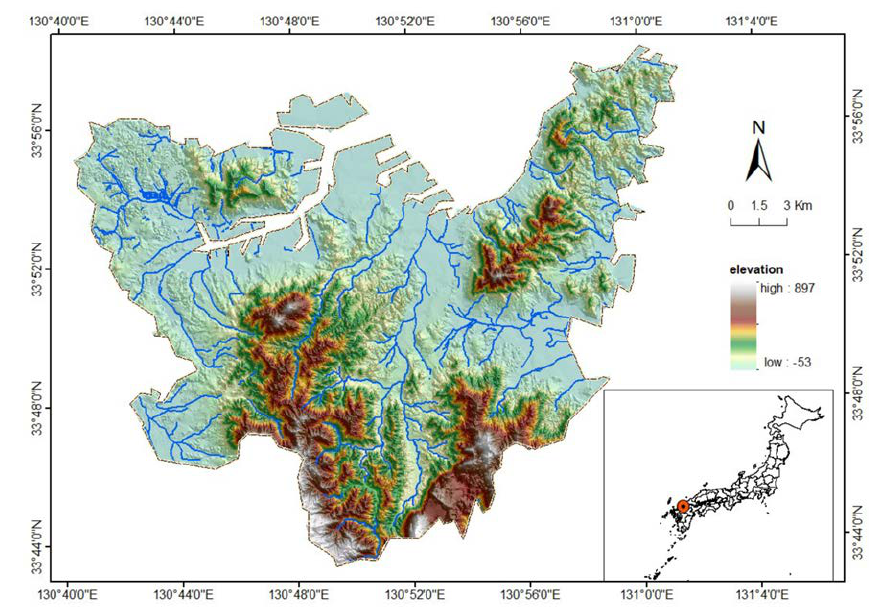
Figure 4. Overview of the study area, Kitakyushu region.